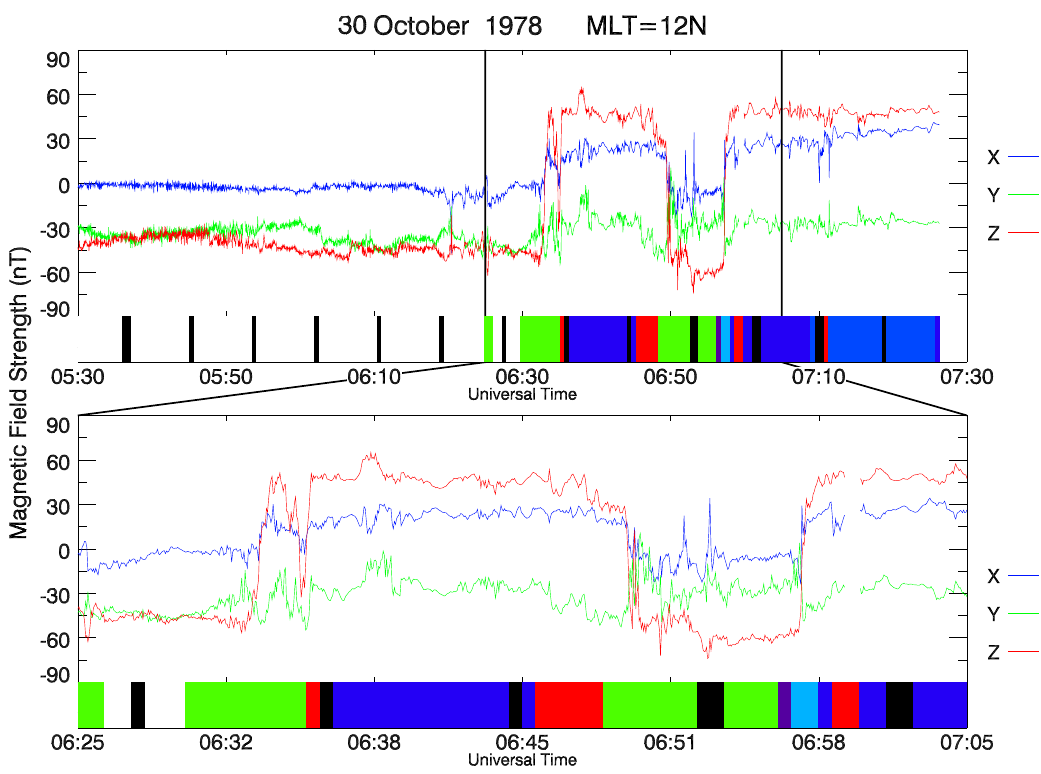
Fig. 8. A plot in the format of Fig. 4 for 30 October 1978 (Day303) from 05:30UT to